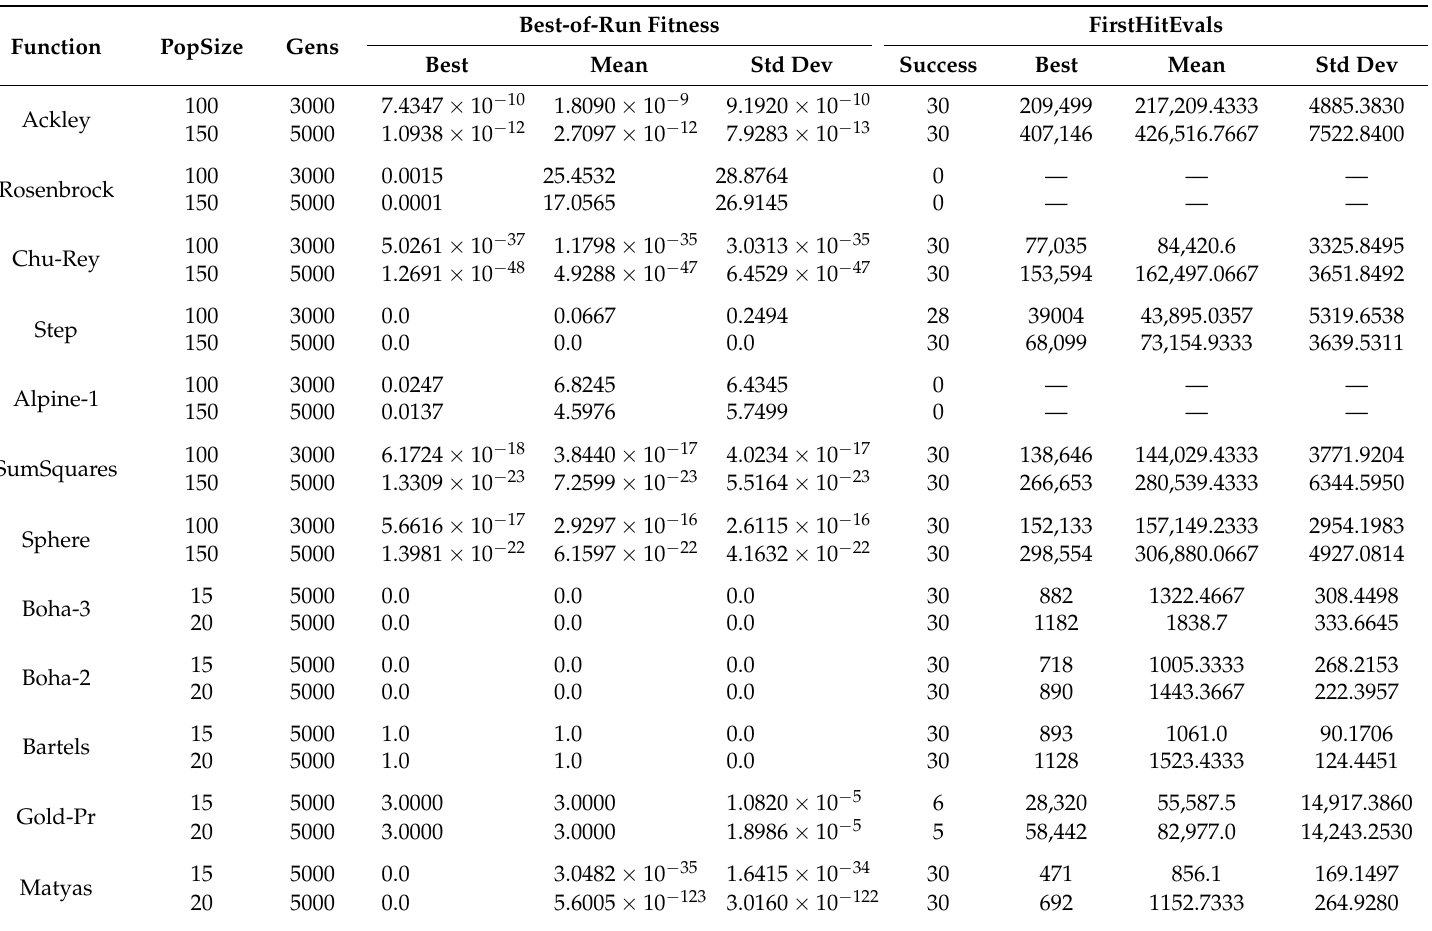
Table 2. Results of SJaya on the 12-function test-suite (each row corresponds to 30 independent runs). Most numbers are shown with rounding at the fourth place after the